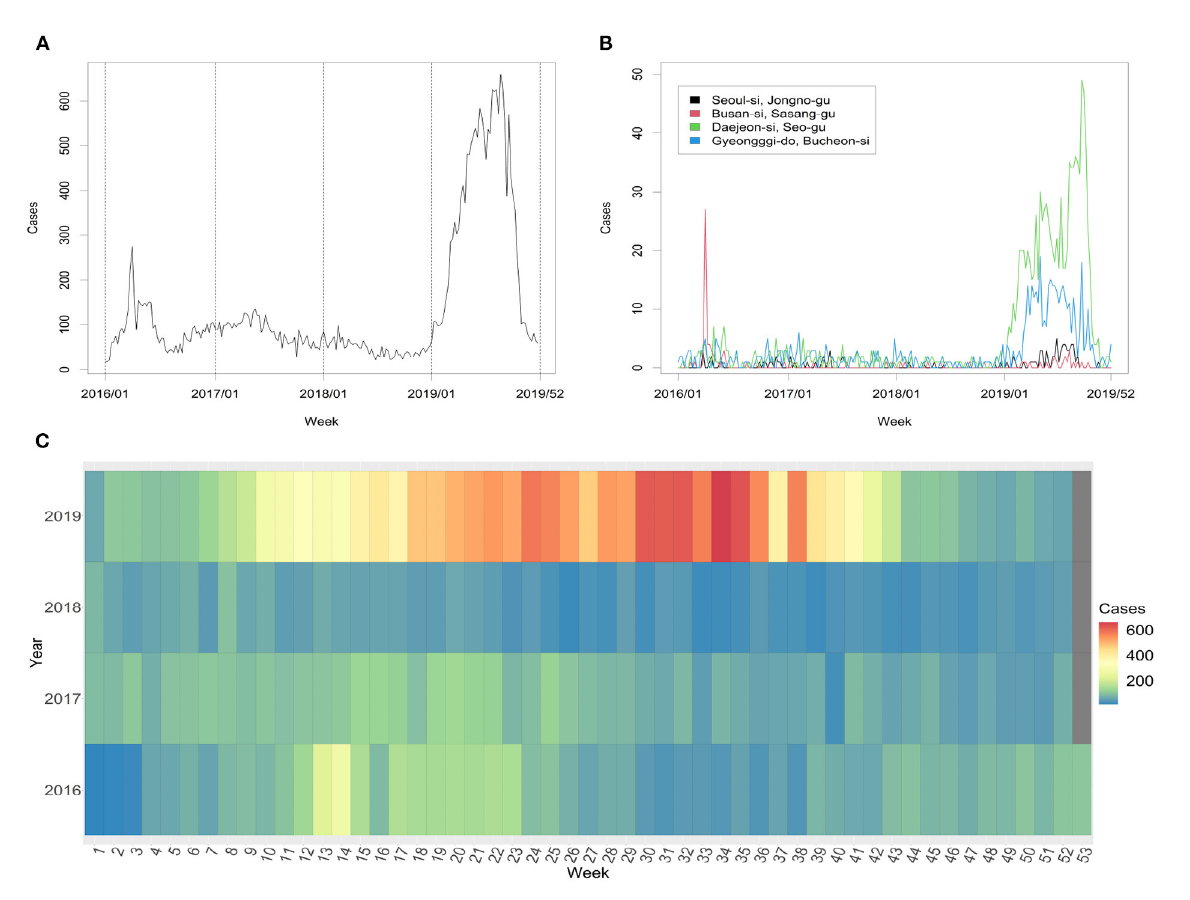
FIGURE1 (A) Number of HAV cases from 2016 to 2019. (B) Weekly HAV cases at selected districts. (C) Temporal distribution of weekly total cases from 2016 to